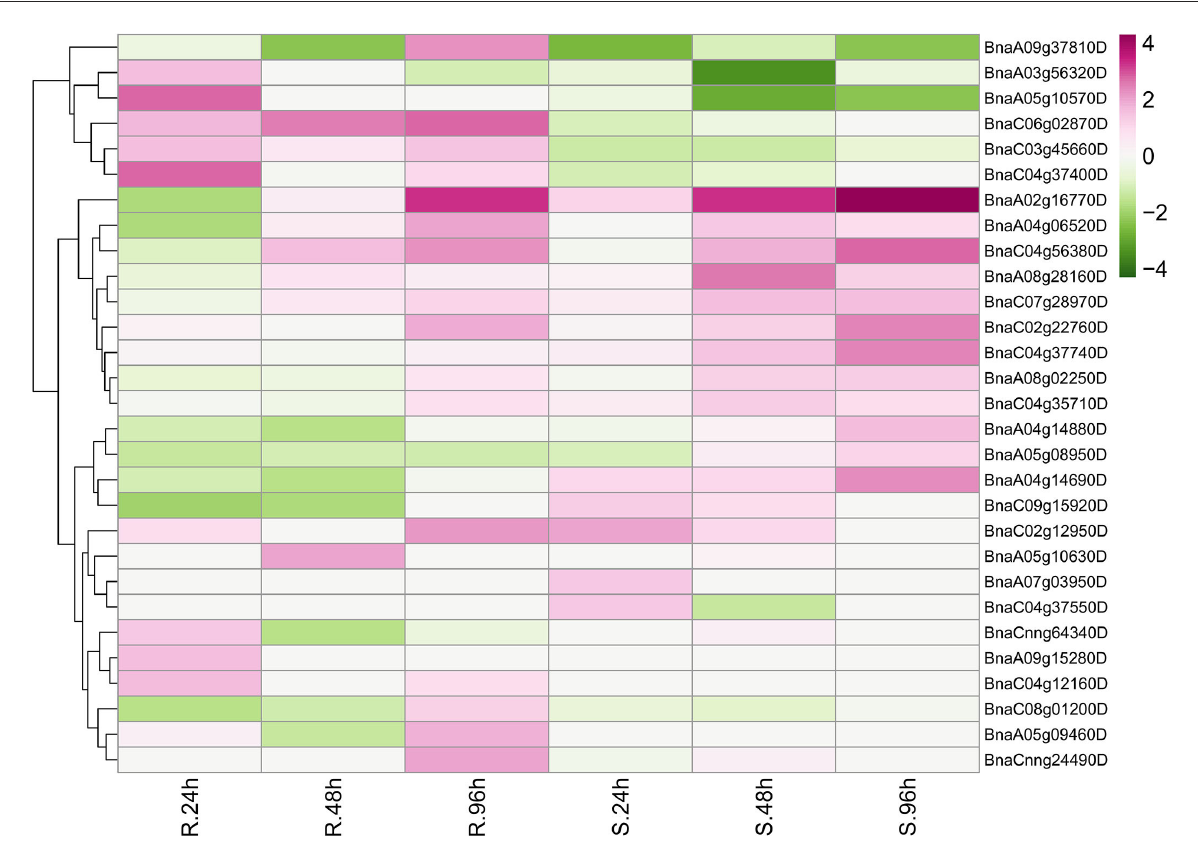
FIGURE7 Upregulated BnRLP s elicited by Sclerotinia sclerotiorum . The expression heat map of upregulated BnRLP genes in the resistant (R) and susceptible (S) B. napus alleles at 24, 48, and 96h post-inoculation by S. sclerotiorum , TPM value derived from the GEO database was used for heat map